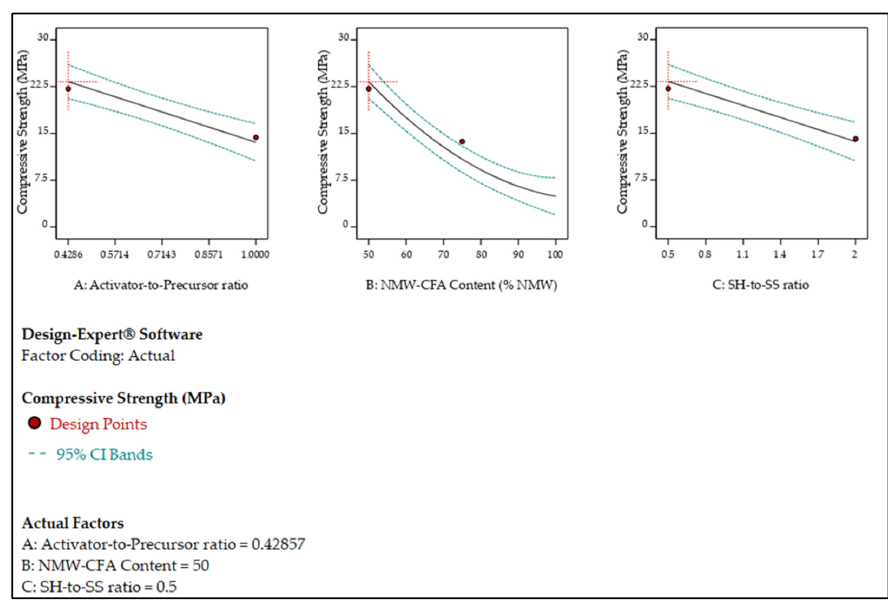
Figure 5. One-factor Figure 5. One ‐ factor plot.